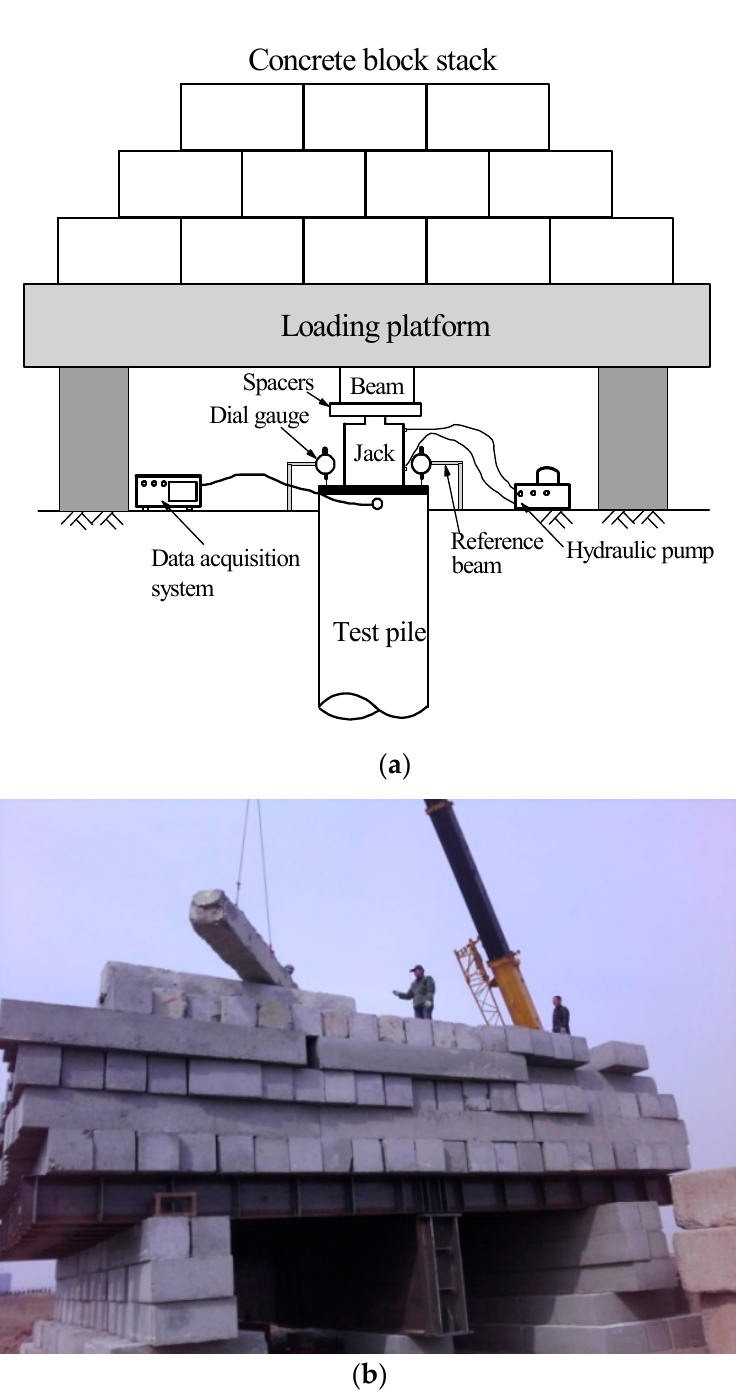
Figure 6. Static loading test of T2. ( a ) Schematic view; ( b ) Static loading test in field.